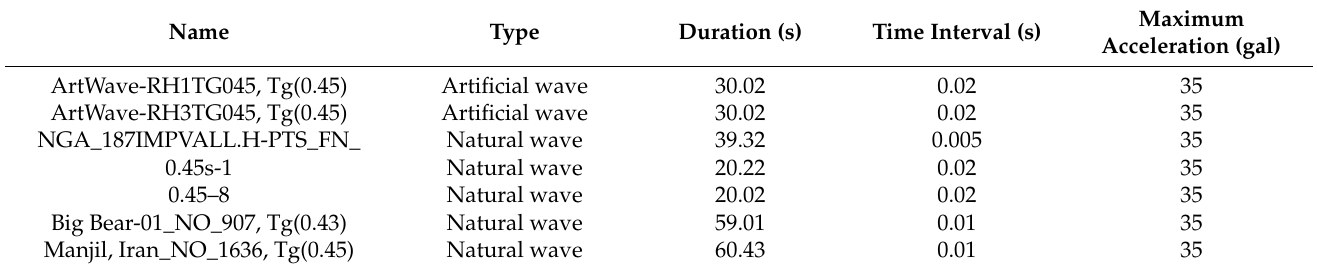
Table 9. Overturning moments of typical structural members and percentage proportions of the total overturning moments in the X and Y directions from the elastic time history analysis.